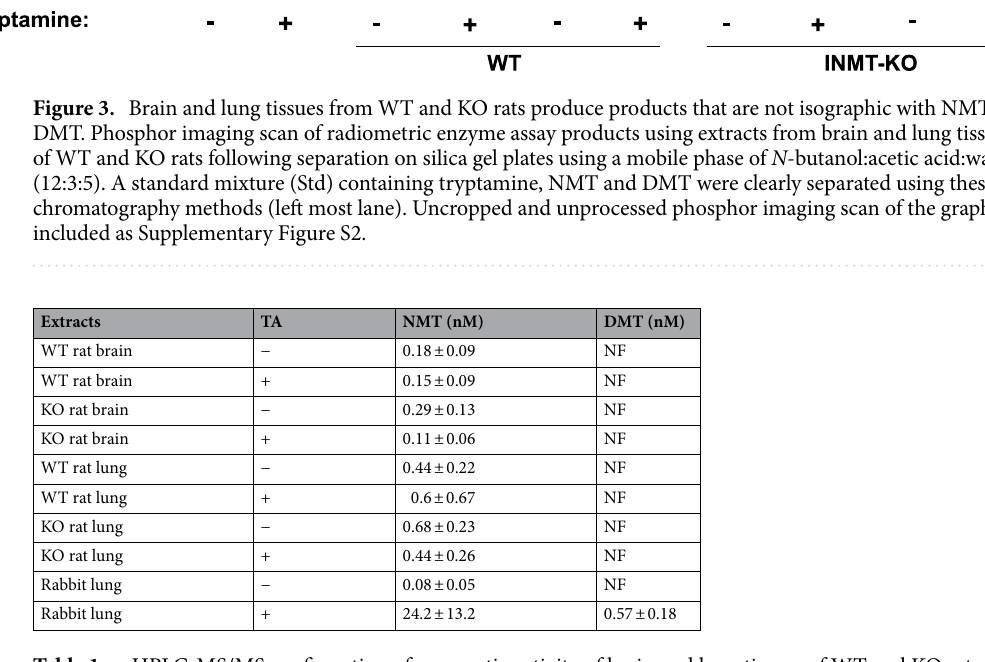
Table 1. uHPLC-MS/MS confirmation of enzymatic activity of brain and lung tissues of WT and KO rats. For rats, values shown are averages of duplicates from each of n = 6 rats per genotype ± standard deviation. For rabbit lung, values shown are averages of a duplicate ± standard deviation. TA = tryptamine, NF = peak not found.